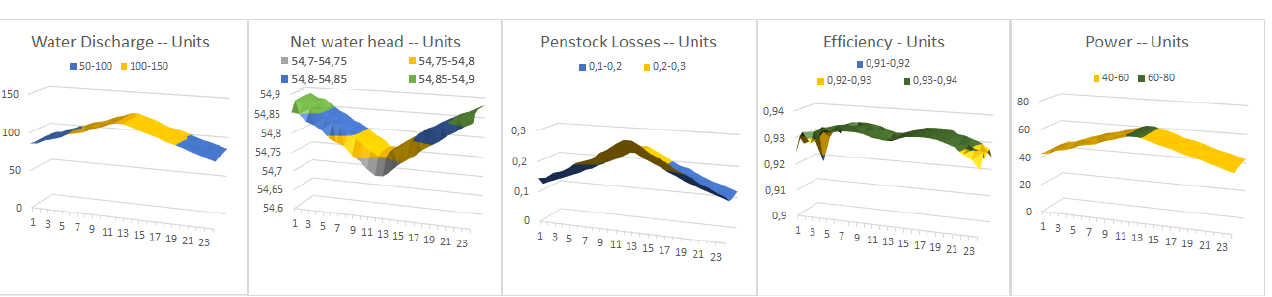
Figure 15. CRO-SL with DE(best/1/bin) and Gaussian Mutation substrates— CRO ( 2 b ,4 ) . Results of Water discharge (m 3 /s). Net water head (m). Penstock (m). Efficiency (%) and Power generated (MW/h). Daily dispatch (24 h).